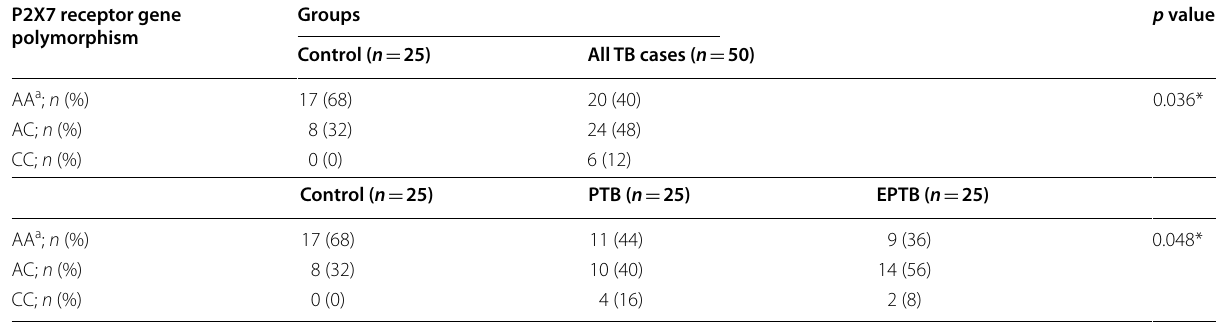
Table 3 Association between P2X7 receptor 1513A/C polymorphism genotypes and the studied groups